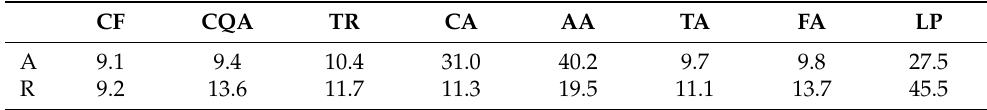
Table 11. Mean percentage error among the numerical and laboratory results for each chemical species and Arabica (A) and Robusta (R)